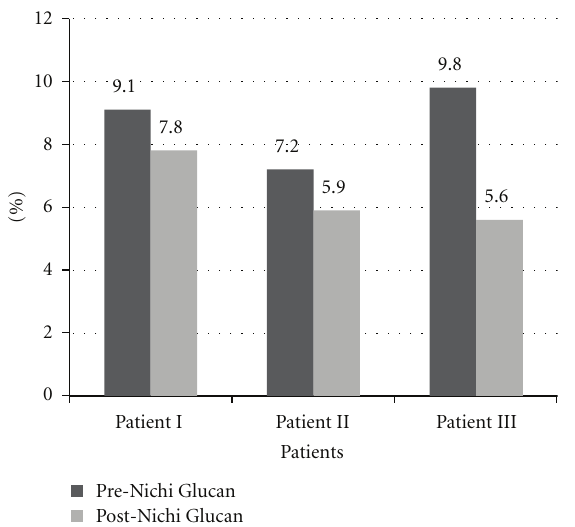
Figure 1: HbA1c Levels before and after food supplementation with Nichi